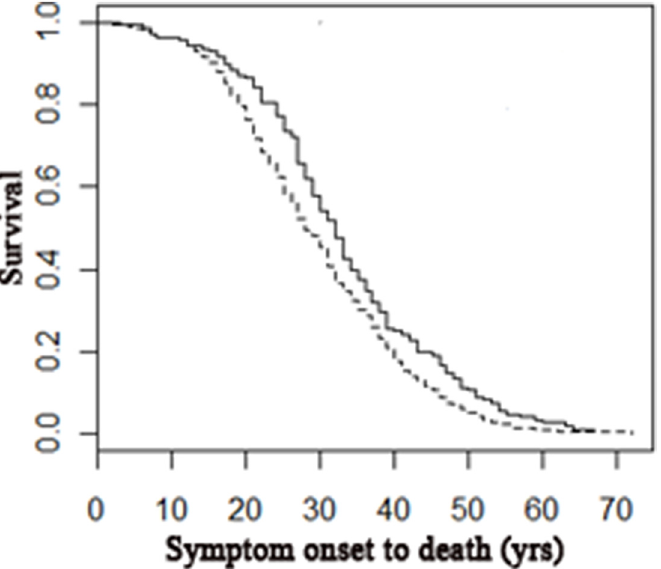
Fig 1. Cox proportional hazard regression model comparing disease length leading to MS-related deaths and unrelated deaths. Those whose death was MS-related had a shorter disease course from symptom onset to death than those whose death was unrelated (R 2 = 0.016, n = 504, p < 0.01; MS death 1.32, 95CI 1.08 – 1.61). Dotted line represents MS-related deaths; solid line represents non-MS-related